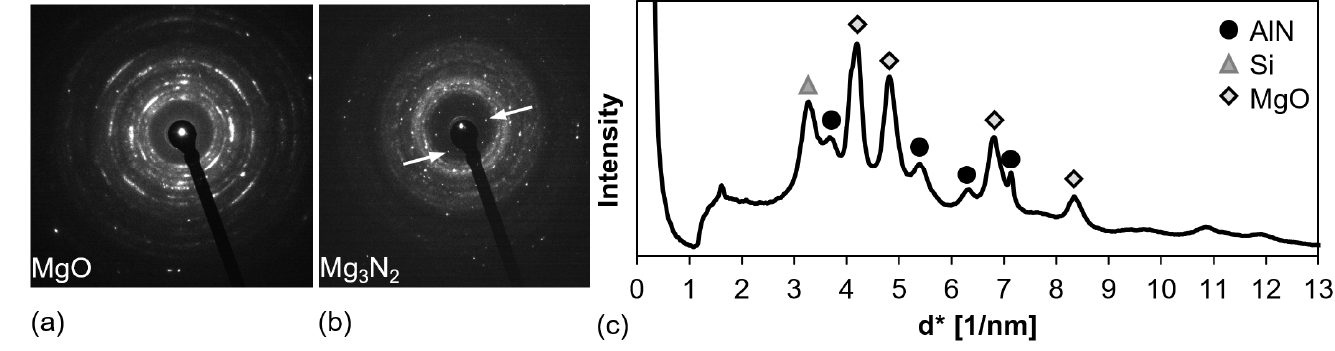
Figure 8. SAED measurements at the transition zone (PN + EBR): diffraction patterns of: ( a ) MgO, ( b ) Mg 3 N 2 , and ( c ) radial intensity distribution of the diffraction pattern.